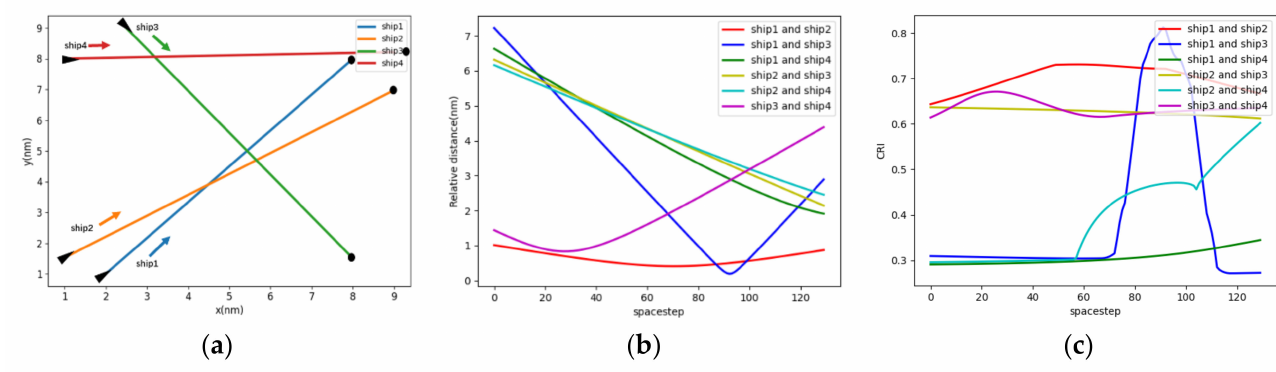
Figure 15. The result of four-ship encounter without measures. ( a ) trajectories; ( b ) relative distance; ( c )